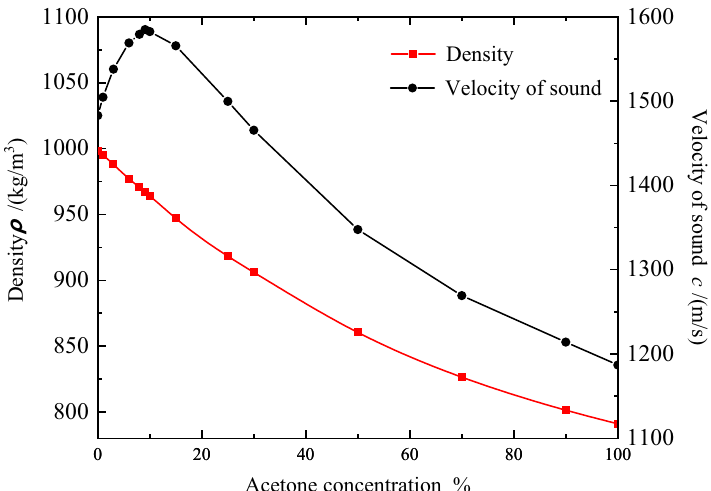
Figure 6. Velocity of sound and density of the 0–100% acetone concentration in water (vinegar